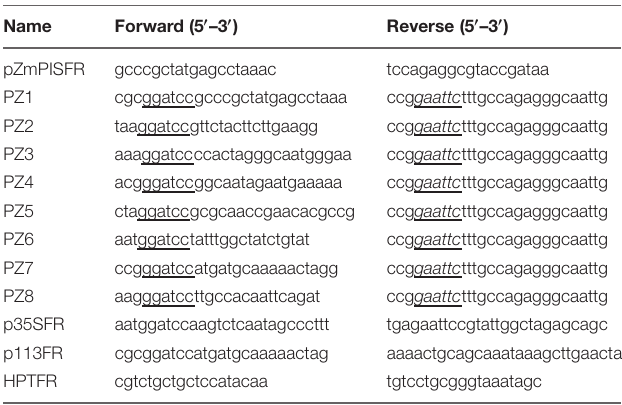
TABLE 1 | Polymerase chain reaction (PCR) primers used in the present